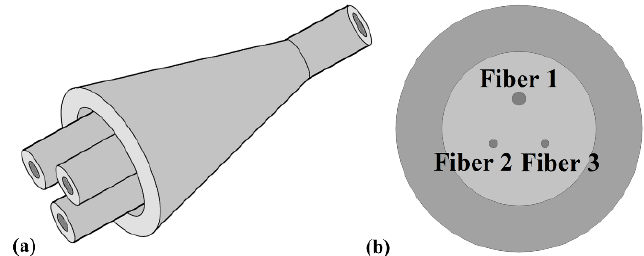
Figure 1. The ( a ) structure and ( b ) cross section of a photonic lantern (PL). Note: ( b ) is not to